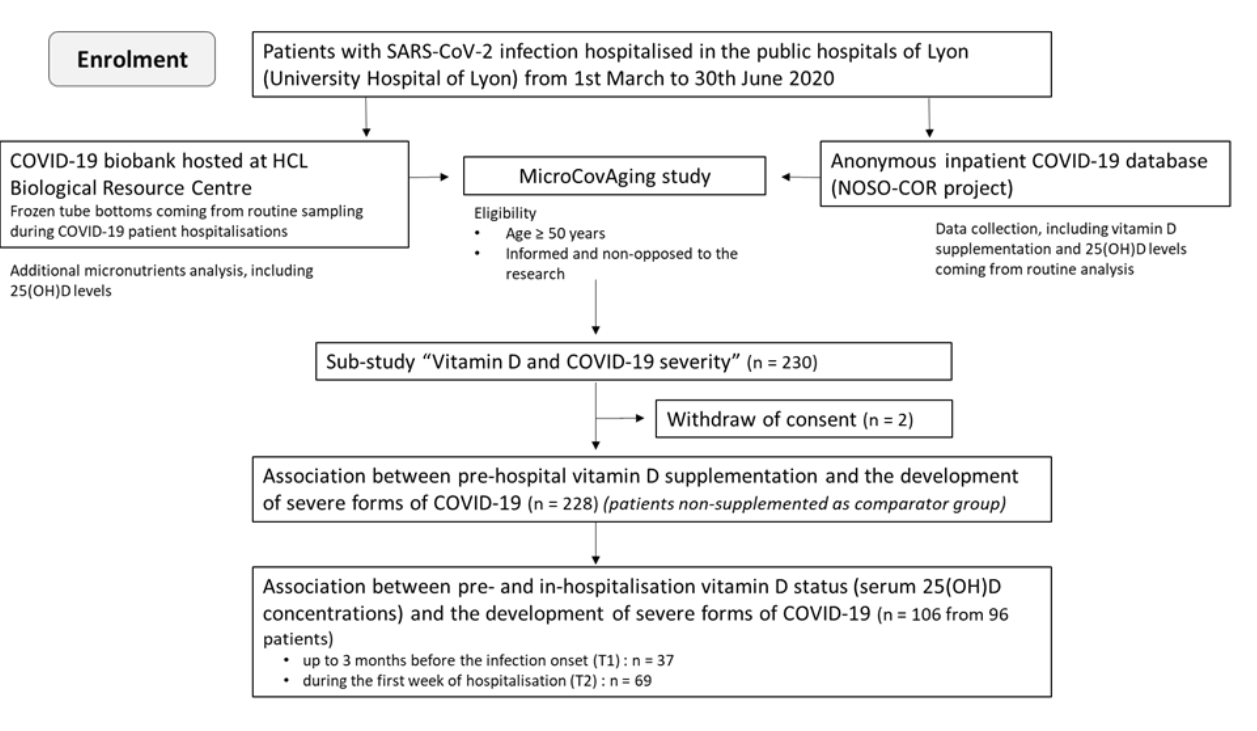
Figure 1. Flow chart summarizing the enrolment of patients included in the study.